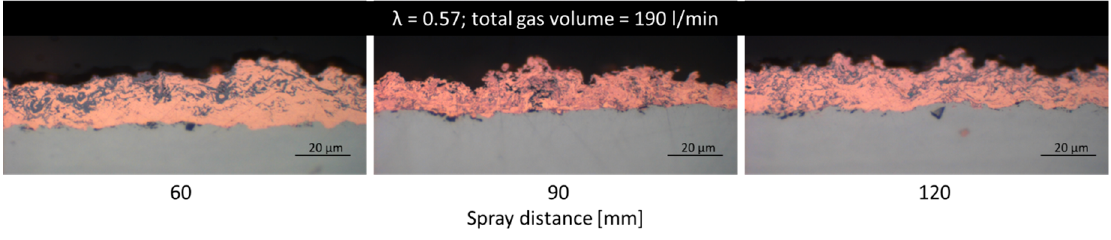
Figure 12. Optical microscope cross-section images of Cu coatings sprayed with a reduced of λ = 0.57 with increasing spray distance (from left to right). Applied spray parameters: λ = 0.57; total gas volume = 190 L/min.